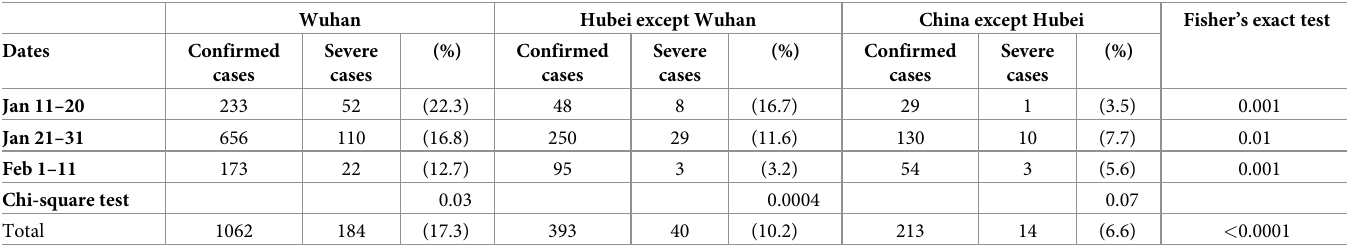
Discussion Preventing nosocomial transmission is a top priority during an epidemic. The consistent higher percentage of COVID-19 infected healthcare workers in severe conditions in Wuhan may be related to the draconian city lockdown and the established of massive quarantines Table 1. Statistical analysis of COVID-19 cases among healthcare workers in